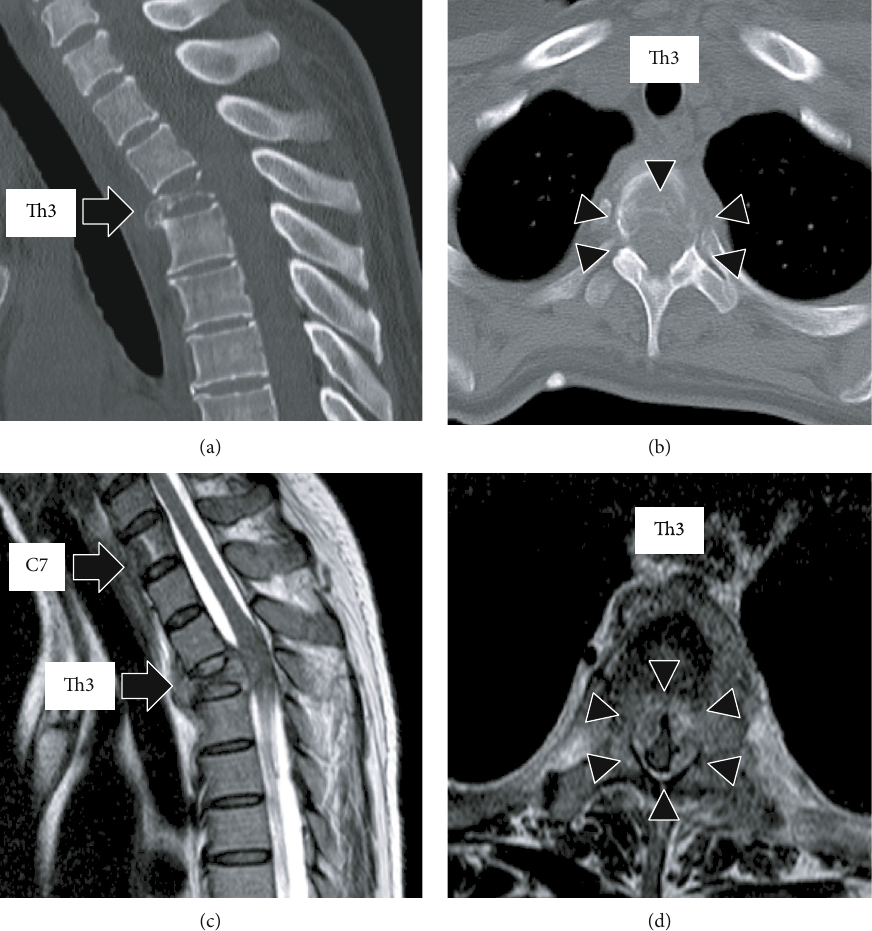
Figure 1: (a, b) Sagittal and axial views of the thoracic spine on computed tomography (CT) before treatment showing a collapsed Th3 vertebral body (arrow) due to the lytic lesion (arrowhead), causing kyphosis. (c, d) Sagittal and axial views of the thoracic spine on magnetic resonance imaging (MRI) showing C7 and Th3 vertebral bodies (arrow) in fi ltrated by the tumor. At the Th3 level, the tumor extends into the posterior vertebral body and bilateral pedicles, resulting in severe compression of the spinal cord